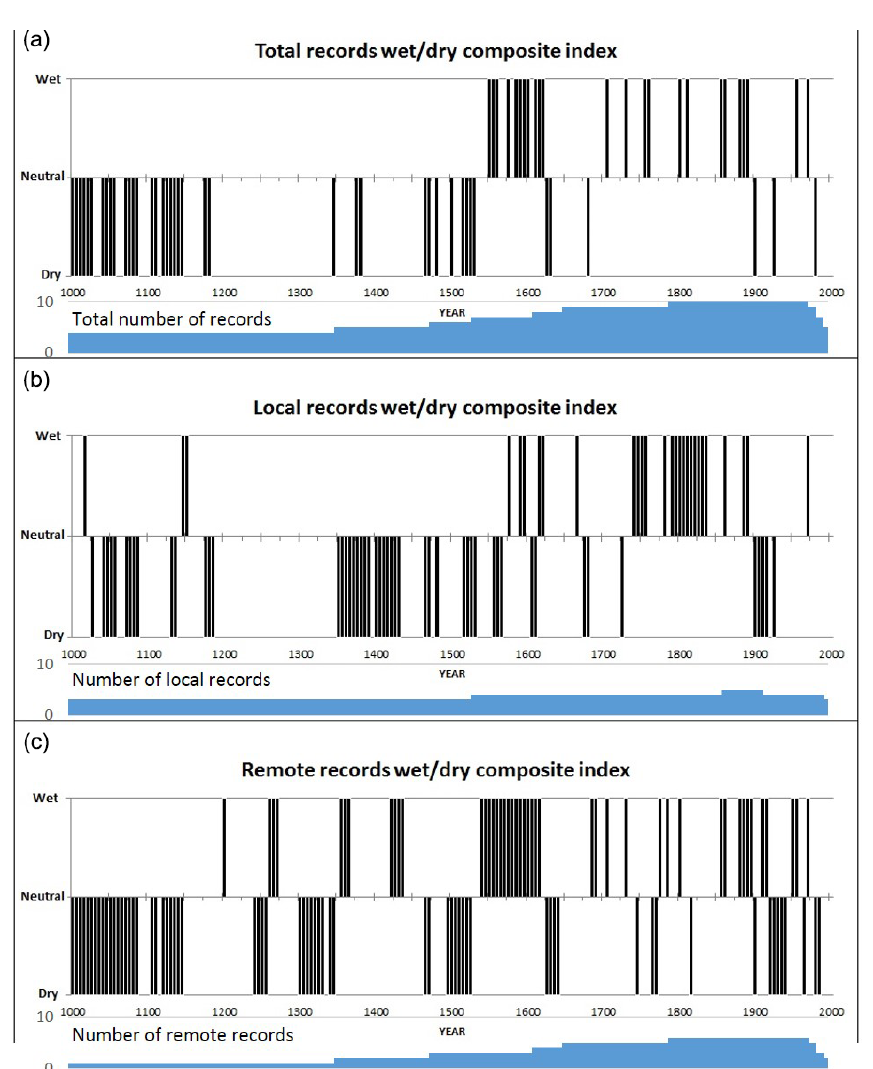
Figure 3. Wet/dry composite index for all palaeoclimate records (a) , just local records (b) , and just remote records (c) . The number of records available for each 5-year period is also shown (11 records in total were used in this study, as per Table